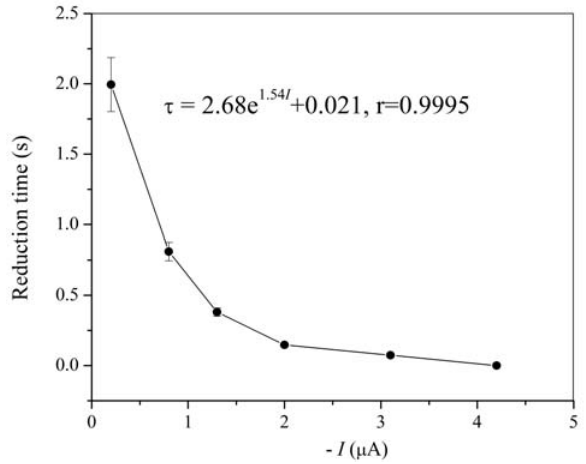
Figure 5. Influence of the reduction current on the riboflavin analytical signal (mean ± 2SD, n = 5). C